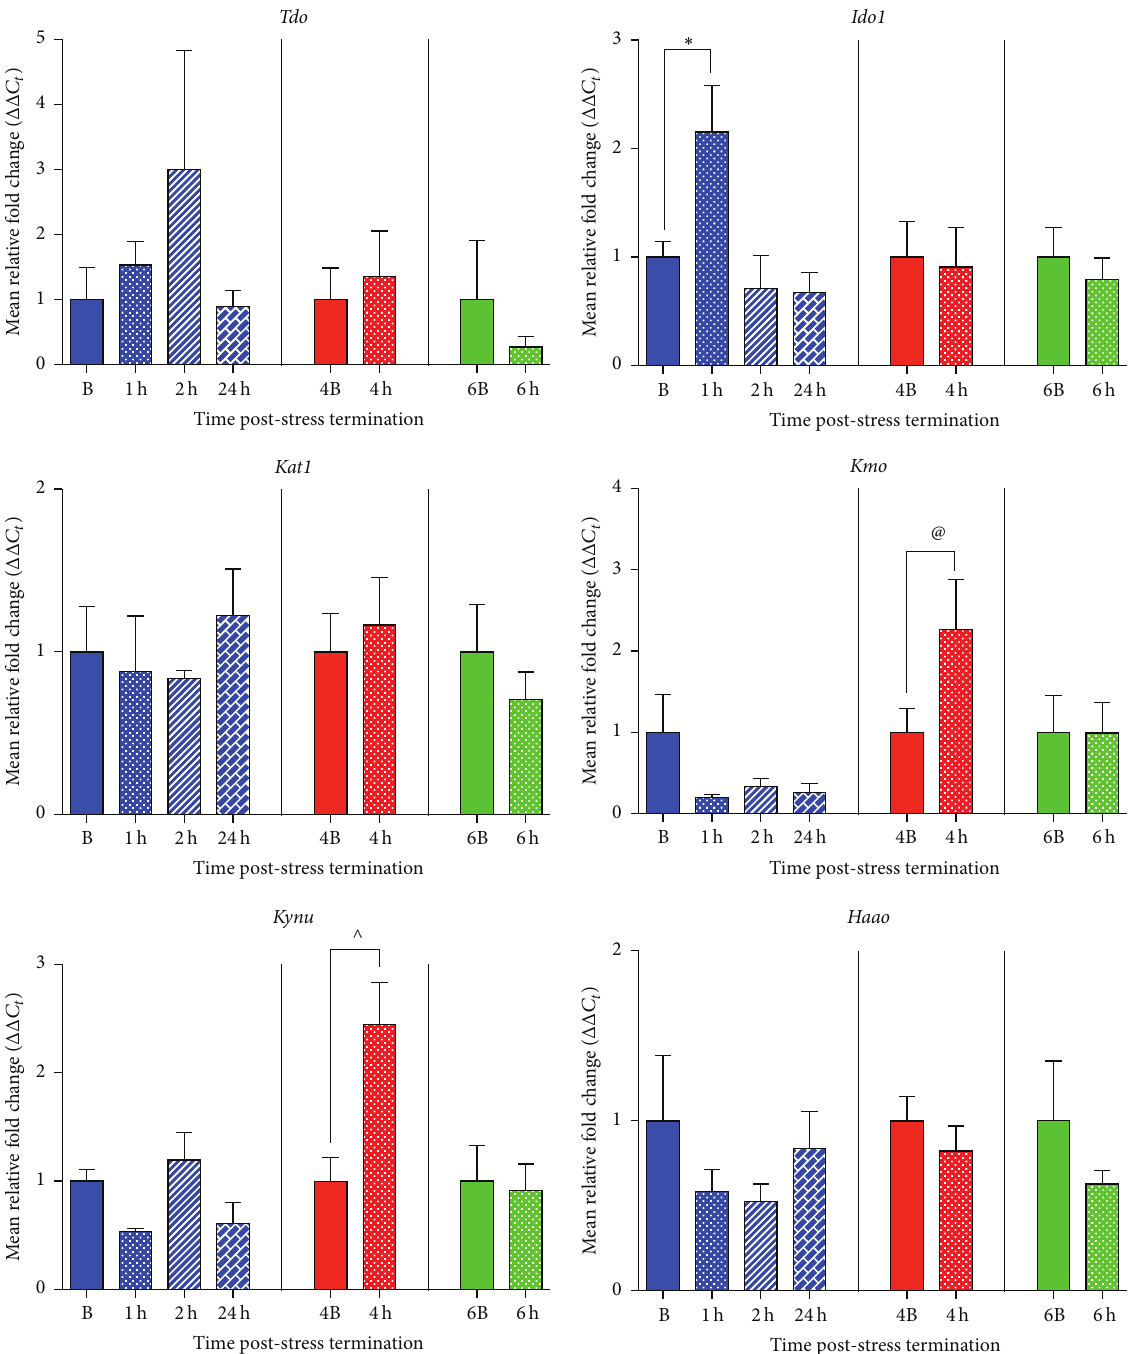
Figure 2: Effects of acute restraint stress on enzymes regulating the kynurenine pathway in the amygdala. mRNA expression levels of tryp- tophan 2,3-dioxygenase ( Tdo ), indoleamine 2,3-dioxygenase 1 ( Ido1 ), kynurenine aminotransferase1 ( Kat1 ), kynurenine 3-monooxygenase ( Kmo ), kynureninase ( Kynu ), and 3-hydroxyanthranilate 3,4-dioxygenase ( Haao ) were examined 1–24 h post-stress termination. All data are represented as means ± SEM (𝑛 = 3 – 6/ group ) . ∗ 𝑝 < 0.05 (in comparison to the B group), ∧ 𝑝 < 0.05 (in comparison to the 4B group), and @ 𝑝 < 0.10 (in comparison to the 4B